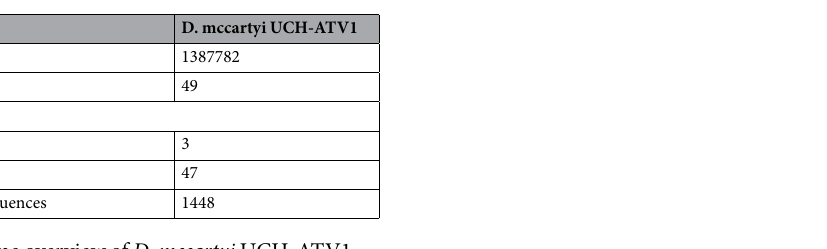
Table 2. Genome overview of D. mccartyi